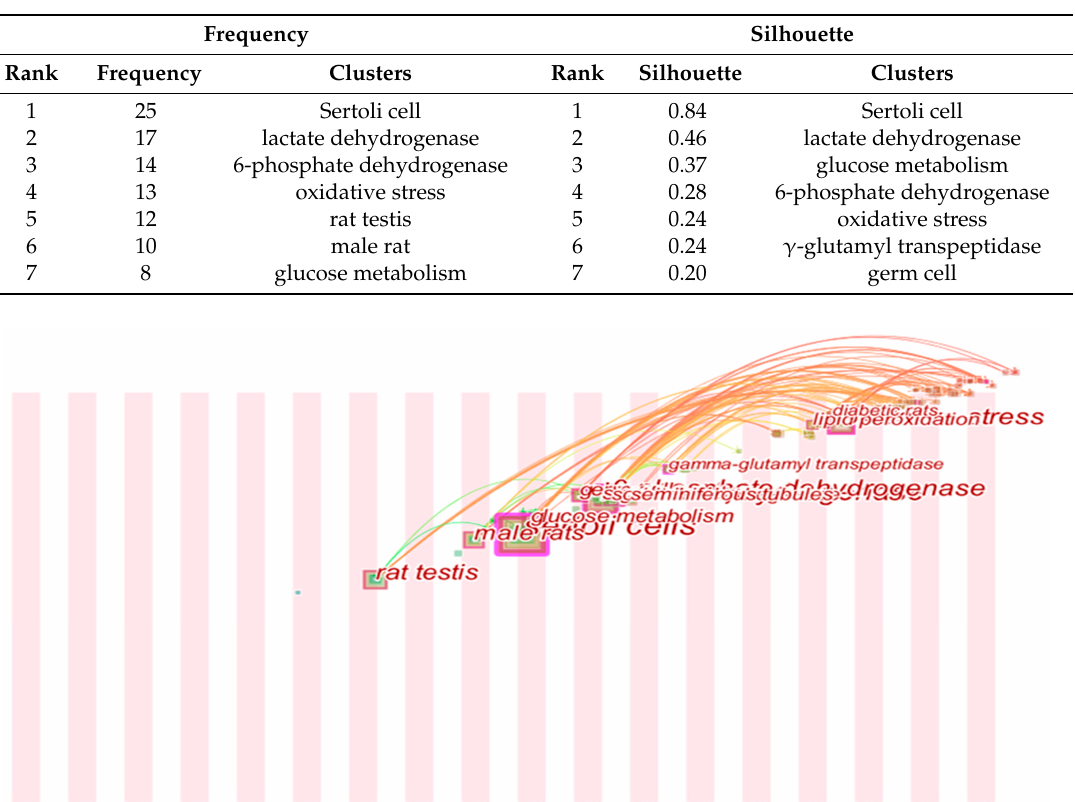
Table 3. The top 7 co-word clusters with high frequency and silhouette in articles examining effects of xenobiotics on glucose metabolism in testes.